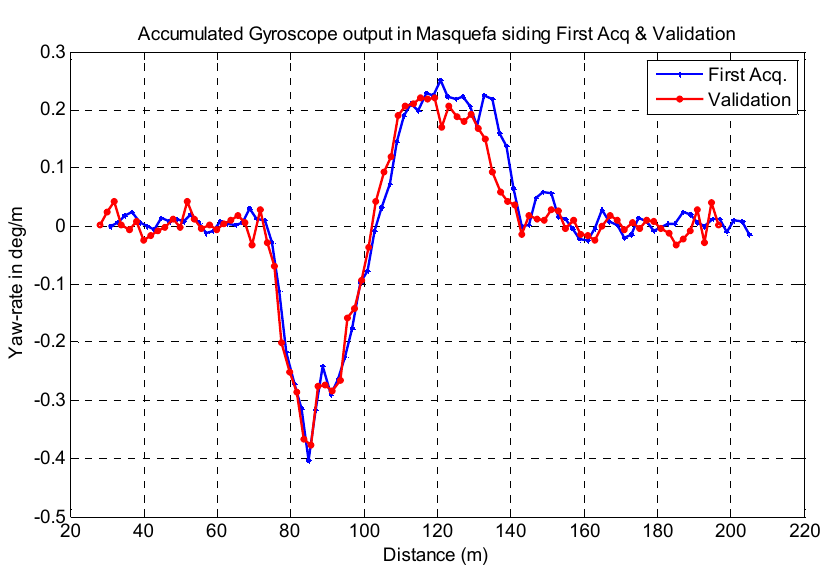
Figure 16. Spatial yaw rate signal obtained in Masquefa siding in the first acquisition and validation